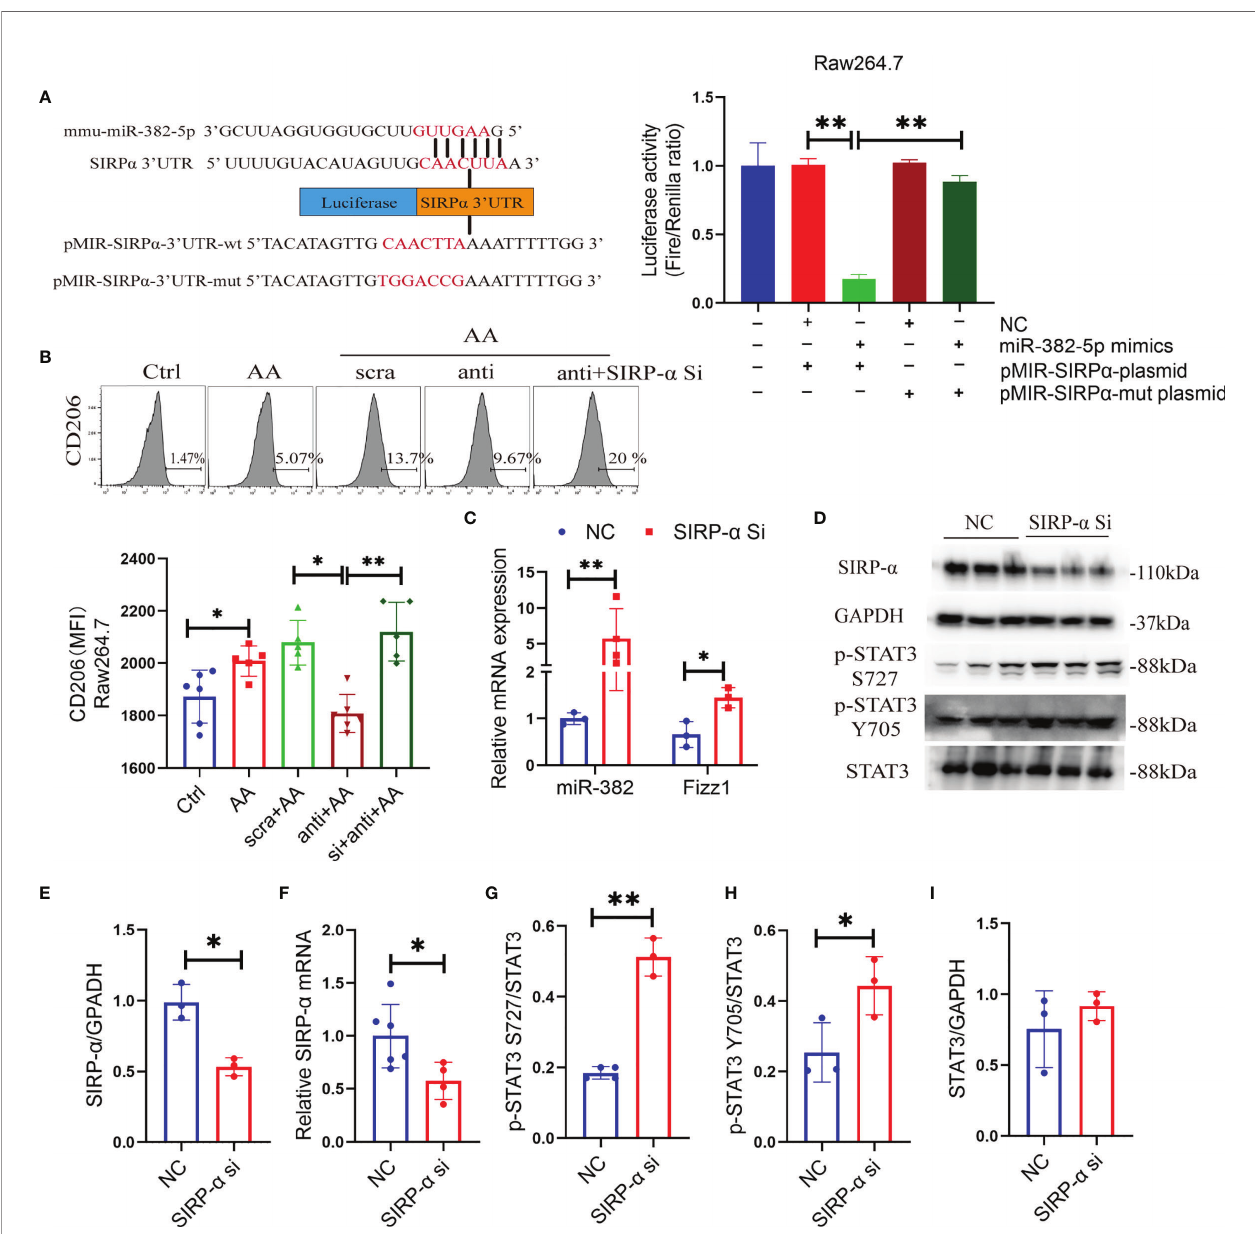
FIGURE 7 | miR-382 promotes macrophage M2 polarization through activation of STAT3 via targeting SIRP- a . (A) Sequence within the SIRP- a 3 ′ UTR targeted by miR-382. Mutations were induced in the SIRP- a 3 ′ UTR sequence. Luciferase activity was quanti fi ed in Raw264.7 cells of the control, NC+ p-MIR-SIRP a plasmid, miR- 382 mimics+ p-MIR-SIRP a plasmid, NC+ p-MIR-SIRP a -mut plasmid, and miR-382 mimic+ p-MIR-SIRP a -mut plasmid groups. Dual-luciferase activity was measured using a Dual-Glo Luciferase Assay System; n = 3 per group. (B) Flow cytometry of CD206 + macrophages in Raw264.7 cells of the control, AA, AA+anti-scramble, AA +anti-miR-382, and AA+anti-miR-382+SIRP- a siRNA groups; MFI of CD206 + macrophages in Raw264.7 among these groups. (C) Transcript levels of miR-382 and Fizz1 in Raw264.7 with SIRP- a siRNA transfection. U6 was used as an endogenous control of miR-382. 18s served as standard of Fizz1. (D) Images of Western blot for SIRP- a , p-STAT3 Y705, p-STAT3 S727, and STAT3 in Raw264.7 cells in NC and SIRP- a siRNA groups. GAPDH served as standard. (E, F) Quanti fi cation of protein and mRNA levels for SIRP- a in Raw264.7 cells in NC and SIRP- a siRNA groups. GAPDH and 18s served as standard, respectively. (G – I) Quanti fi cation of protein expression for p-STAT3 S727, p-STAT3 Y705, and STAT3 in Raw264.7 cells in NC and SIRP- a siRNA groups. *P < 0.05; **P < 0.01;